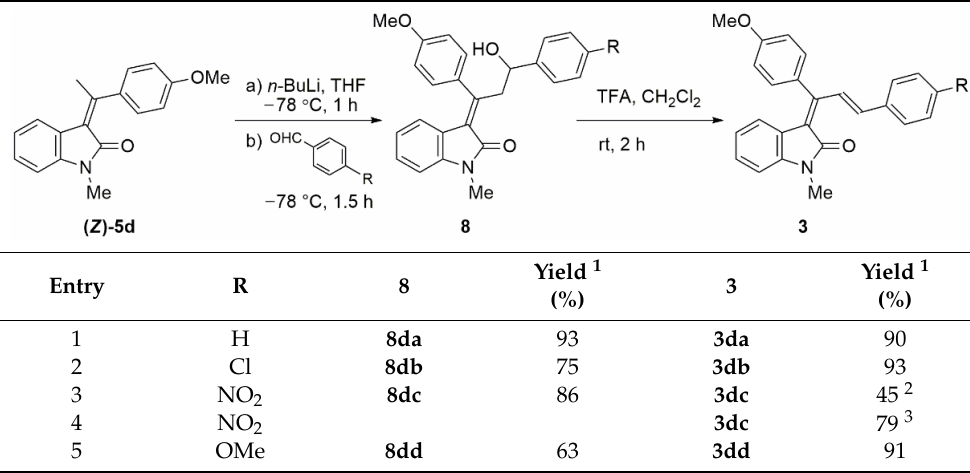
Table 3. Substrate scope of the aldol/dehydration strategy from ( Z )-5d